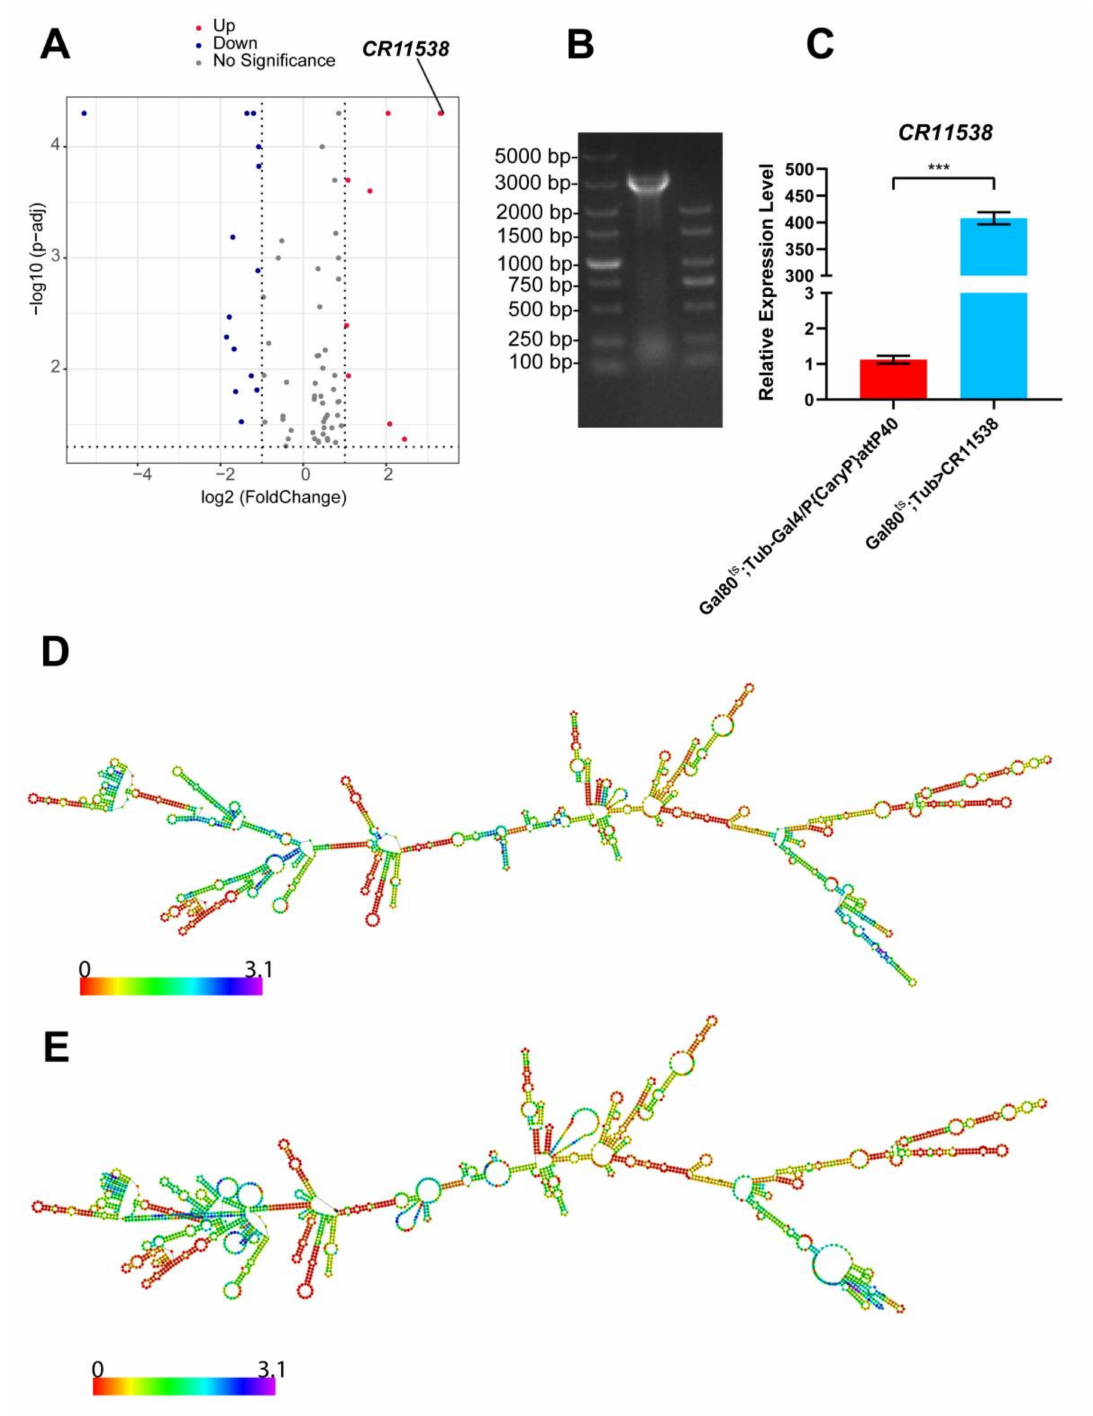
Figure 1. LncRNA-CR11538 is highly expressed after M. luteus stimulation. ( A ) Volcano map showing these differentially expressed lncRNAs in RNA-seq between PBS-treated and M. luteus -infected w 1118 flies. ( B ) PCR was performed using a forward primer for pUAST-attB and a reverse primer for lncRNA-CR11538 . ( C ) The lncRNA-CR11538 expression level was detected in the CR11538-overexpressing flies, normalized to their control levels. Minimum free energy method ( D ) and thermodynamic ensemble method ( E ) were used to predict its secondary structure on RNAfold Webserver. For all tests, p value < 0.05 was considered as statistically significant. *** p < 0.001 vs. the control